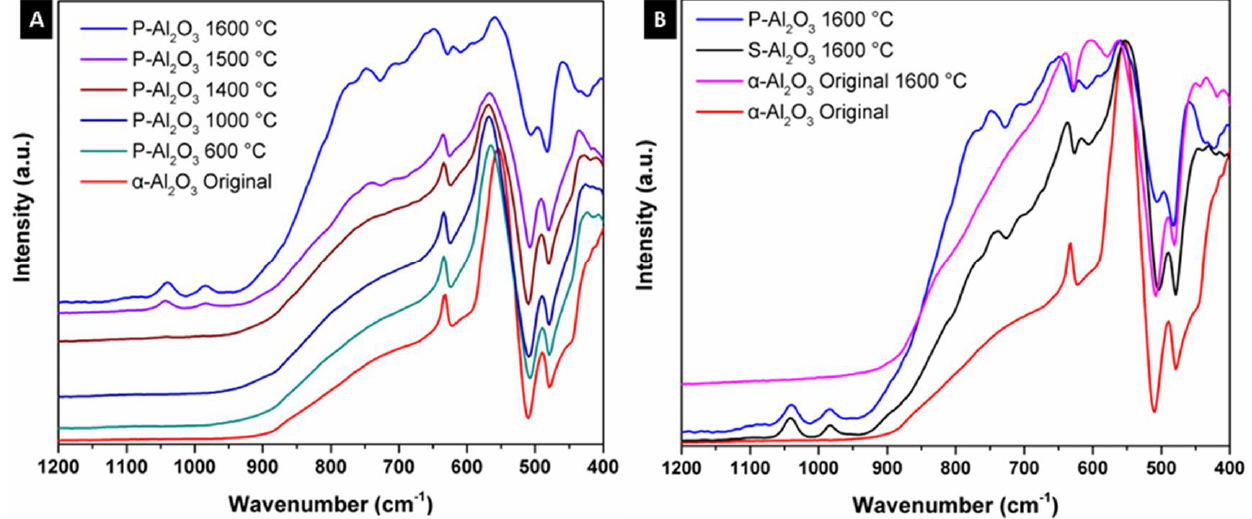
Figure 2. Infrared spectra of the alumina powders and sphere treated at different temperatures: ( A ) powdered sample (P-Al 2 O 3 ) and ( B ) sphere (S-Al 2 O 3 ) .